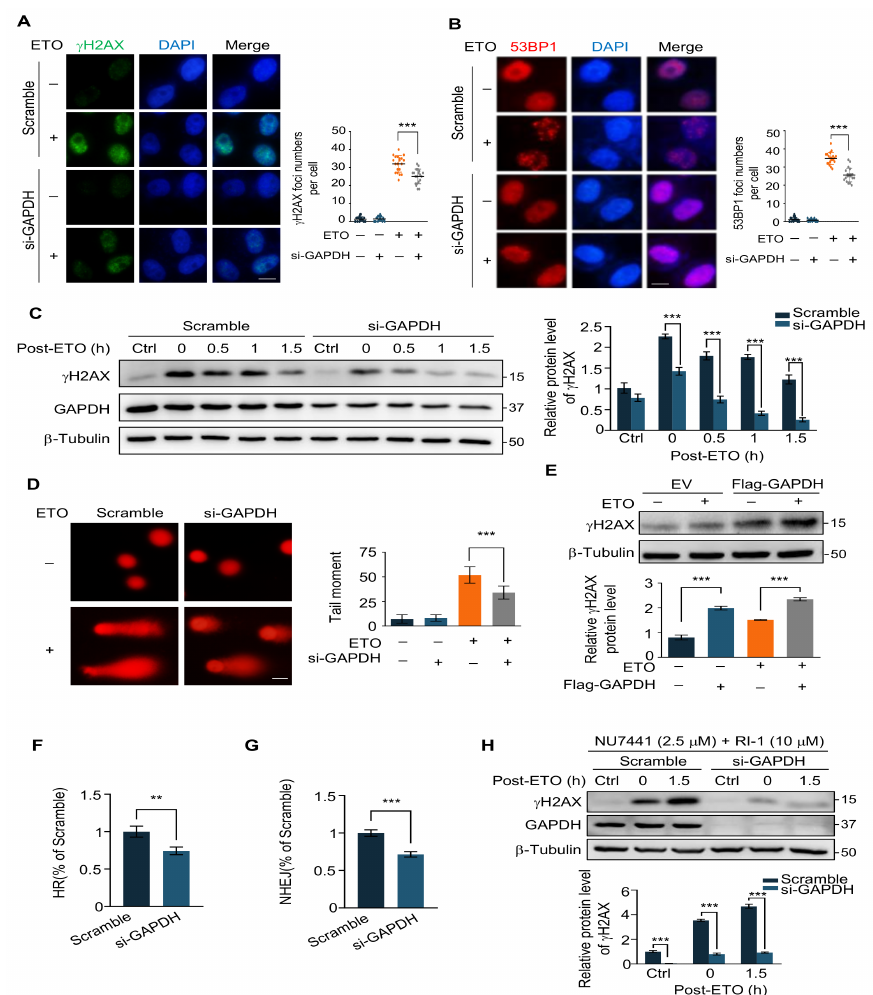
Figure 3. GAPDH deficiency protects cancer cells is not attributed to increased DNA damage repair. ( A ) Immunofluorescence images ( left ) of γ H2AX in HeLa cells transfected with scramble siRNA or si-GAPDH after 20 µ M ETO treatment for 2 h. DNA was stained with DAPI (blue). Quantification ( right ) of γ H2AX foci/cell. Scale bar, 10 µ m. ( B ) Immunofluorescence images ( left ) of 53BP1 in HeLa cells transfected with scramble siRNA or si-GAPDH after 20 µ M ETO treatment for 2 h. DNA was stained with DAPI (blue). Quantification ( right ) of 53BP1 foci/cell. Scale bar, 10 µ m. ( C ) Immunoblot ( left ) and quantification ( right ) of γ H2AX in control or GAPDH knockdown HeLa cells with 20 µ M ETO treatment for different recovery times. ( D ) Comet assay images ( left ) showing the tail moment ( right ) of control and GAPDH knockdown HeLa cells with or without 20 µ M ETO treatment. Scale bar, 100 µ m. ( E ) Immunoblot ( upper ) and quantification ( lower ) of indicated proteins in HeLa cells transfected with an empty vector and Flag-GAPDH were treated with or without 20 µ M ETO. ( F ) The relative HR efficiency of U2OS cells were transfected with scramble siRNA and siGAPDH. ( G ) The relative NHEJ efficiency of U2OS cells was transfected with scramble siRNA and siGAPDH. ( H ) Immunoblot ( upper ) and quantitative analysis ( lower ) of γ H2AX levels in HeLa cells transfected with scrambled siRNA and si-GAPDH for 24 h were treated with NU7441 and RI-1 for 2 h, and then treated with ETO following different recovery times. Data represented as mean ± SD of at least three independent experiments. p values are from student’s t -tests. ** p < 0.01; *** p <